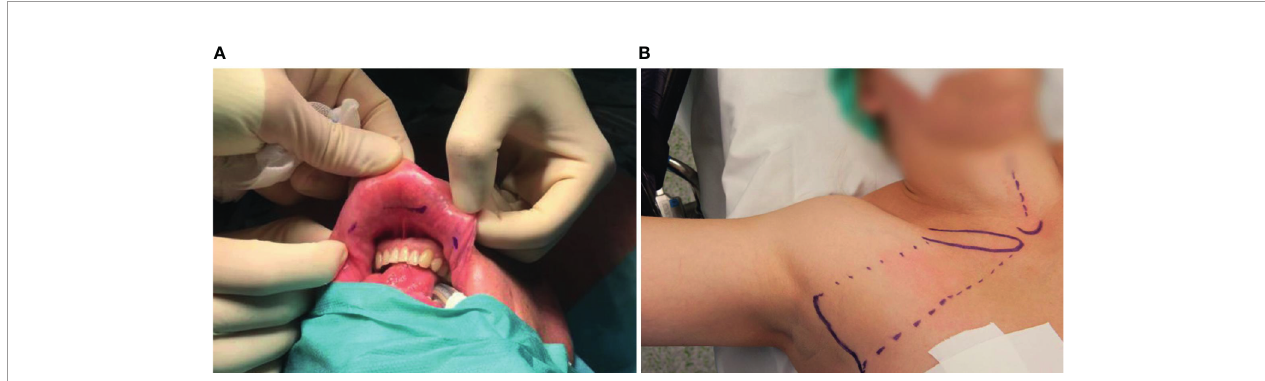
FIGURE 1 | Preoperatively marked patients whowillundergo (A) TOETVA (7).Three incisions willbemadeinthe oralvestibule, one for the camera and two laterally for dissection and coagulation instruments; and (B) RATS (8). The incision site ismarked laterally.The dotted lines mark the bordersof the surgical